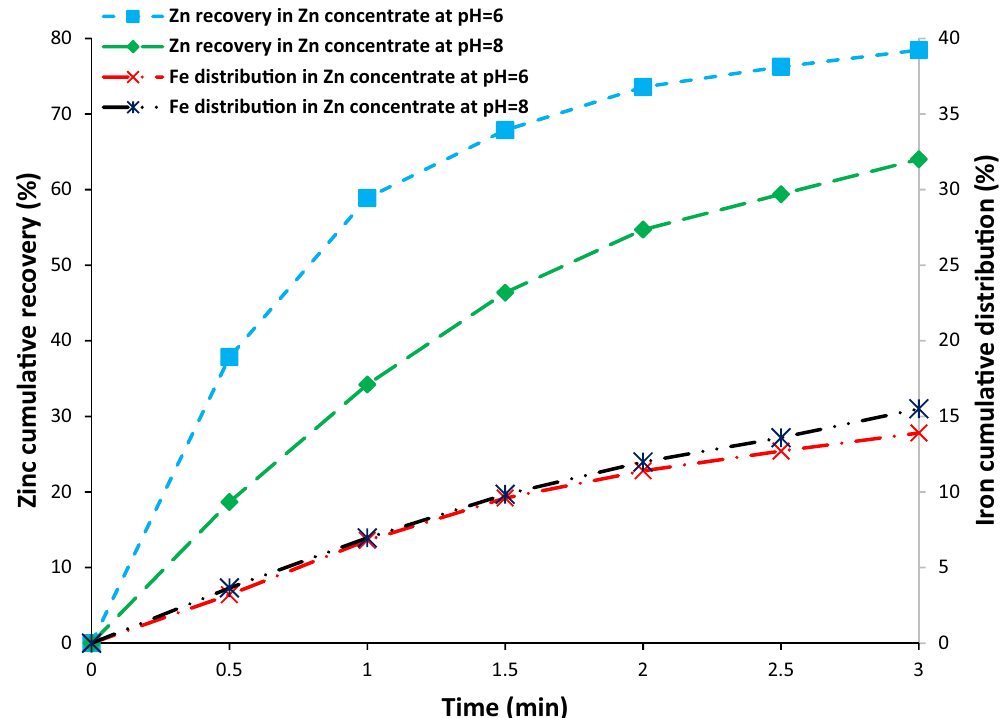
Figure 11. Flotation kinetic of zinc, and iron at pH of 6 and 8 in the zinc flotation stage.